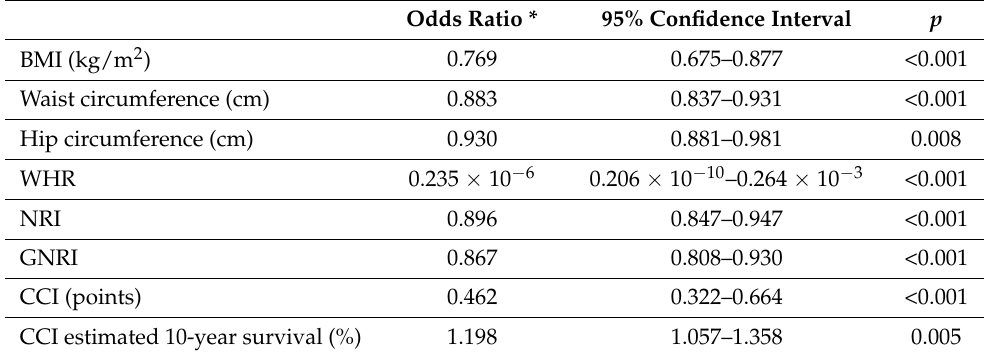
Table 3. Results of univariable logistic regression analysis, with the type of diabetes as the depen- dent